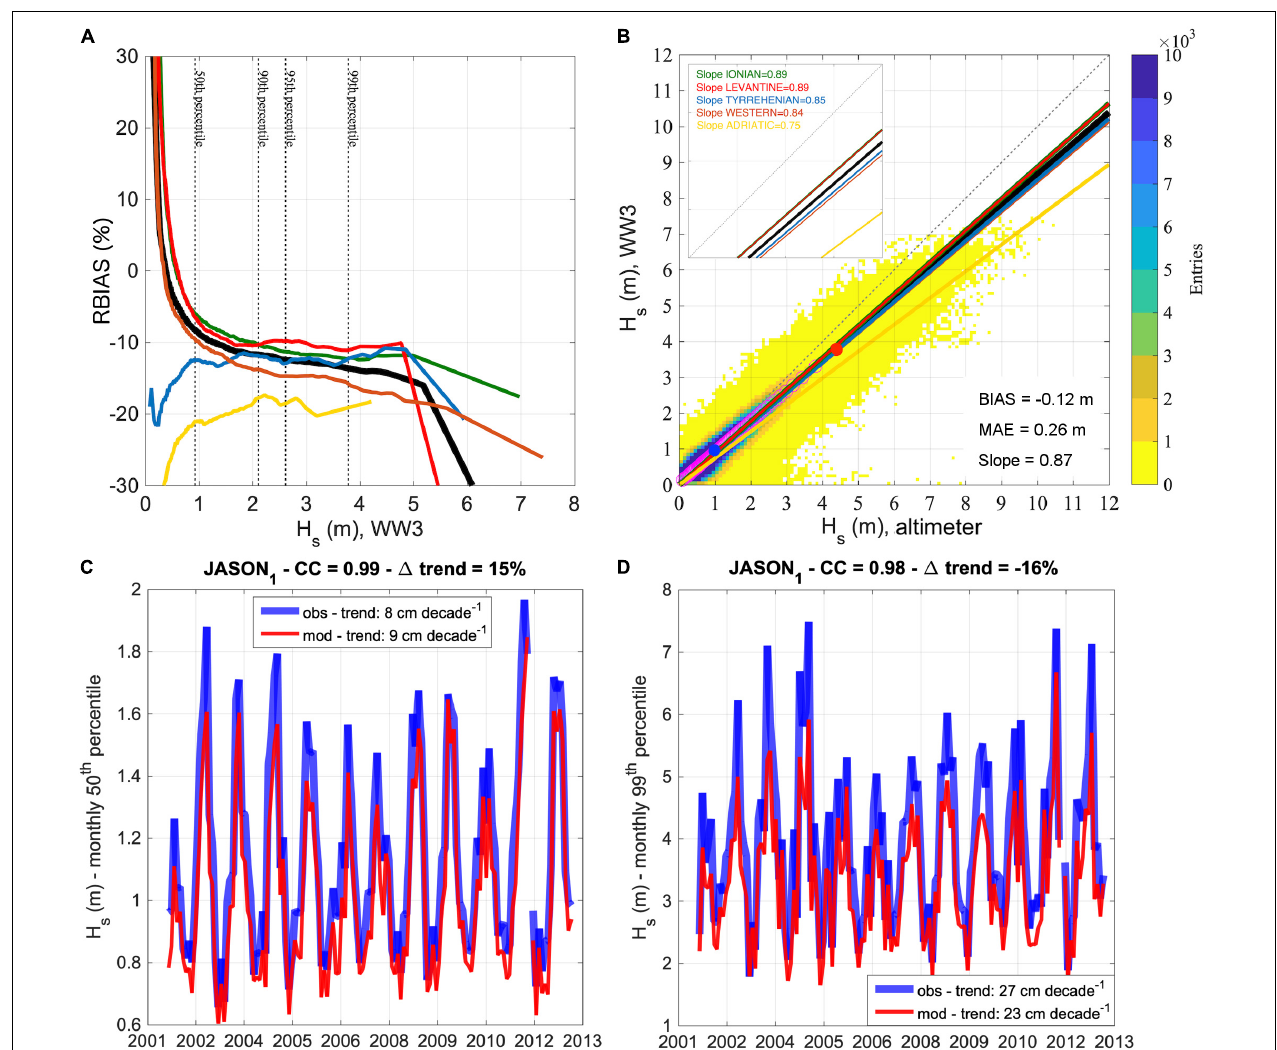
FIGURE 3 | Performance of the WW3 wave hindcast in the MS and sub-basins against satellite altimetry (missions in Supplementary Table 1 ), August 1991–December 2019. [panel (A) ] Relative H s bias RBIAS as a function of H s , WW 3 , with relevant percentile levels for the MS relative bias indicated by dashed lines. Black line: MS; green line: Ionian; red line: Levantine; blue line: Tyrrhenian; orange line: Western; yellow line: Adriatic. [panel (B) ] Scatter plot and statistics for the MS. Purple circles are the Q-Q plot, with the blue dot denoting the 50th percentile and the red dot the 99th percentile. [panel (C)] Observed (JASON-1) and modeled (WW3) monthly 50th percentiles of H s over the MS. Correlation coefficients (CC) and relative model-observation difference in trends are indicated in title. [panel (D) ] Observed (JASON-1) and modeled (WW3) monthly 99th percentiles of H s over the MS. Panel description as in panel (C)